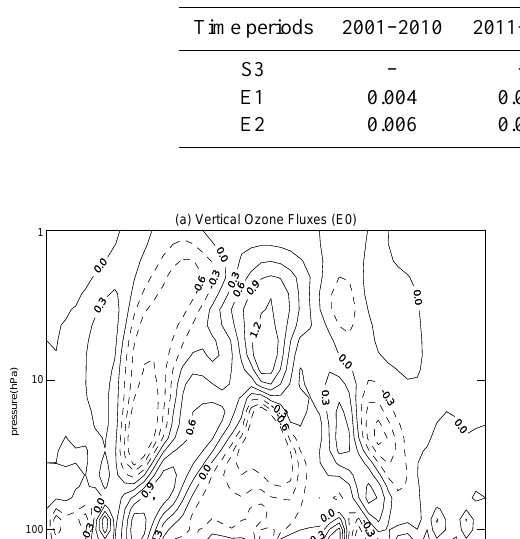
Table 4. N 2 O ODP values estimated from simulations S3, E1, and E2. The ODP values of N 2 O are calculated by equation (2). Simulations S0 and E0 are used as the control runs for estimating the ozone changes caused by N 2 O in simulations S3, E1, and E2. The ozone changes caused by CFC11 are estimated by the differences between runs S4 and S0. For E1 and E2 runs, the ODP values of N 2 O are estimated over every 10 years of simulation time.